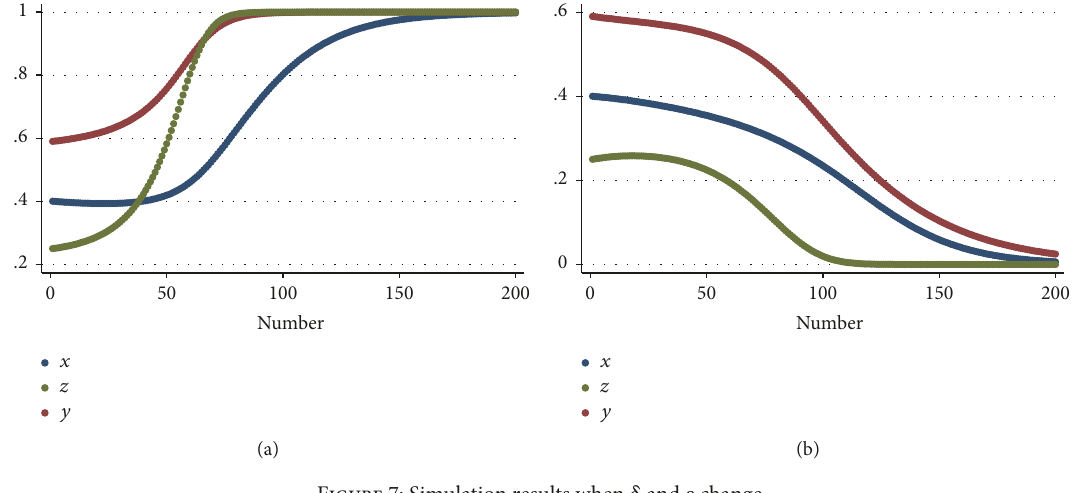
Figure 7: Simulation results when 𝛿 and 𝜀